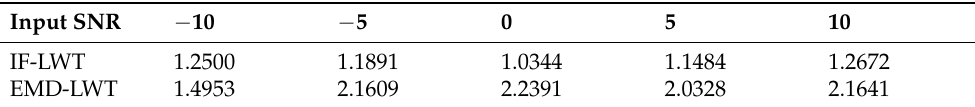
Table 2. Comparison between IF and EMD based methods in terms of execution time (in seconds) at various input SNR